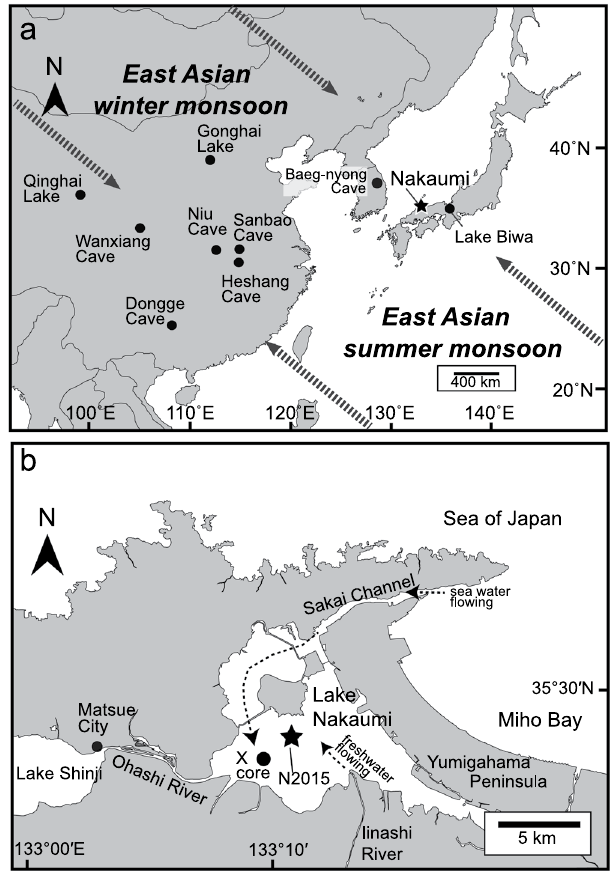
Figure 1. Map showing East Asia and Lake Nakaumi. ( a ) The location of Lake Nakaumi and the regions where the EASM records were recognized. The dotted arrows show the window directions. ( b ) The locations of the N2015 (star) and X (filled circle) cores. The dotted lines indicate the directions of freshwater and seawater